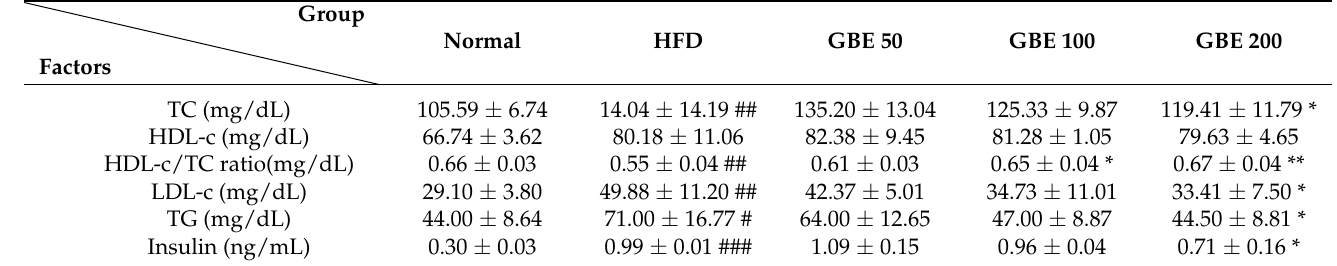
Table 1. Data are expressed as mean ± SD. # p < 0.05 ## p < 0.01 and ### p < 0.001 versus the